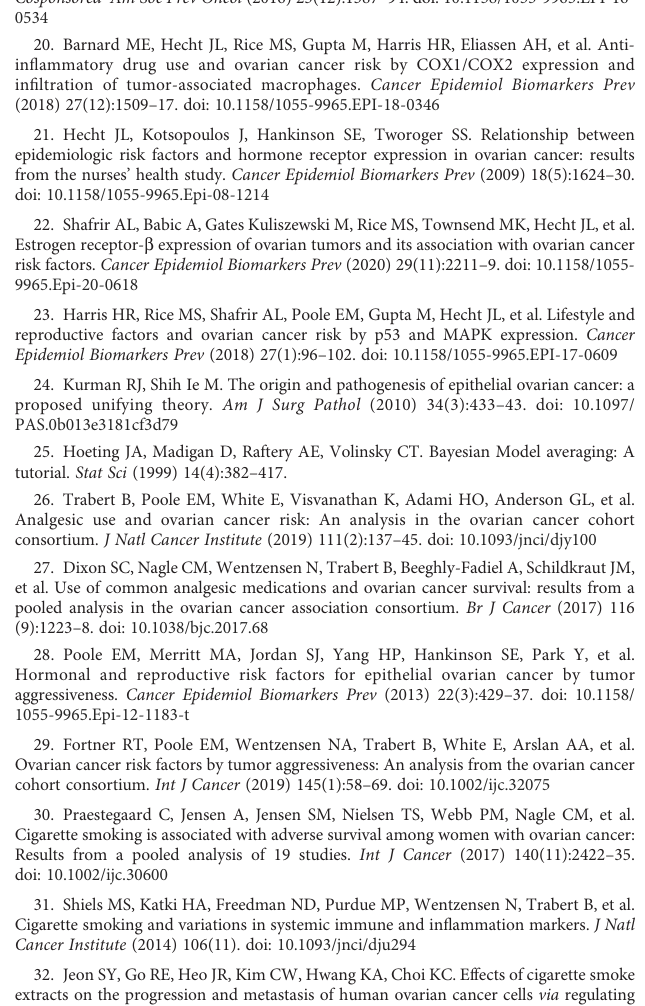
Prediction modeling of optimal debulking status using epidemiologic/clinical predictors and tissue markers in Type 2 tumors. Average posterior means and associatedaverageposteriorprobabilitiesofepidemiologic/clinicalpredictorsand tissue markers being selected in the fi nal prediction model of optimal debulking status and area under the curve (AUC) of the prediction models using Bayesian model averaging among invasive epithelial ovarian cancer cases (n=150) in NHS/ NHSII/NEC. We assessed the posterior probability of 24 tissue markers in addition to our base model of clinical predict score, which included epidemiologic/clinical variables that had ≥ 20% posterior probability of being selected in the fi nal